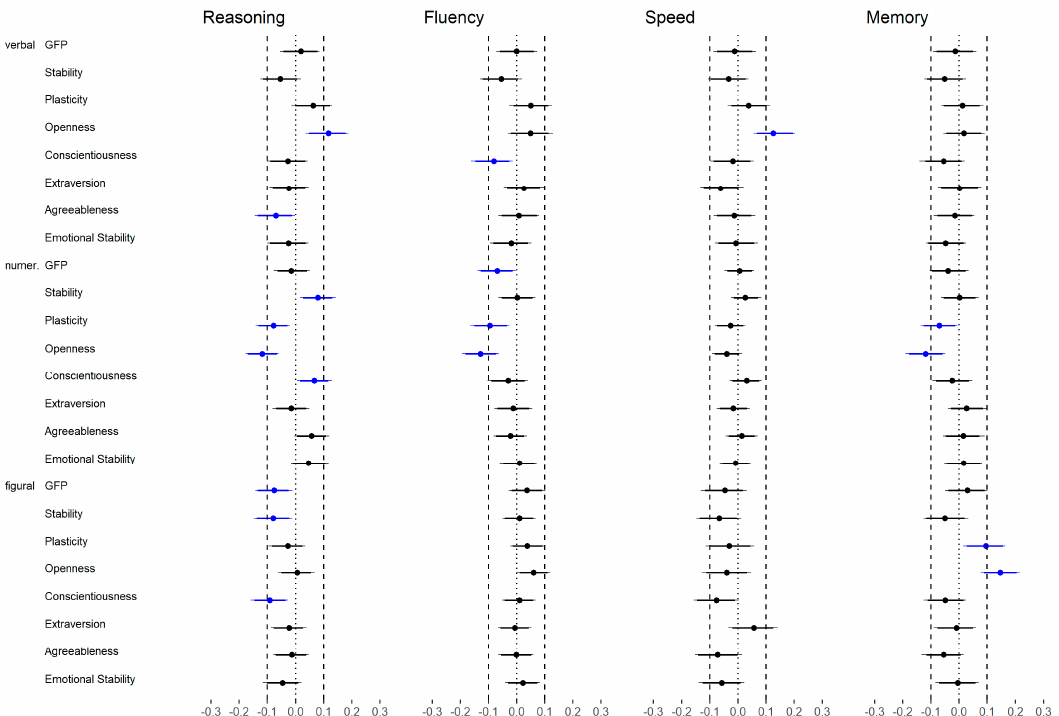
Figure 14. Study 2: Evaluation of the Brunswik Symmetry principle with regard to intelligence. Differences in correlations between specific abilities (medium level) and low-level abilities. Blue lines indicate substantially different correlations based on an equivalence testing approach.